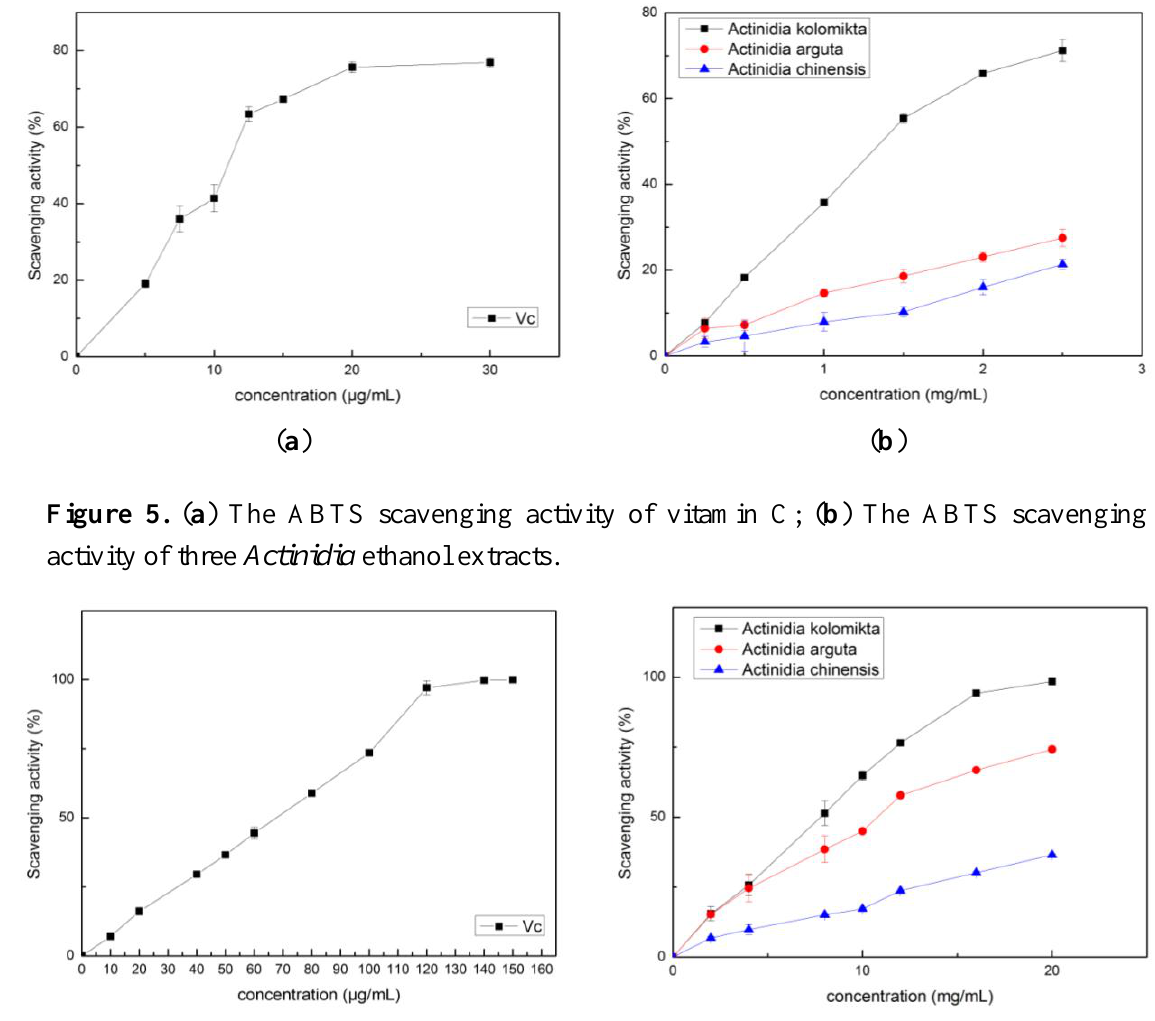
Figure 4. ( a ) The DPPH scavenging activity of vitamin C; ( b ) The DPPH scavenging activity of three Actinidia ethanol extracts.